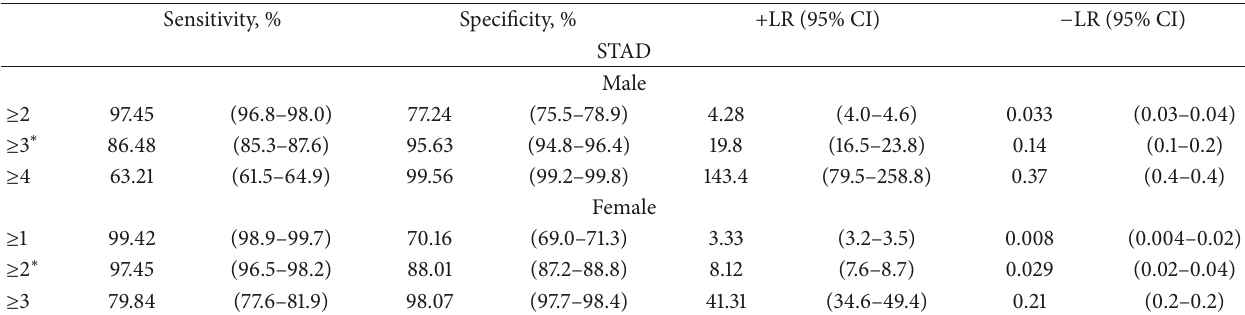
Table 3: Cut-off values, sensitivities, and specificities of STAD.